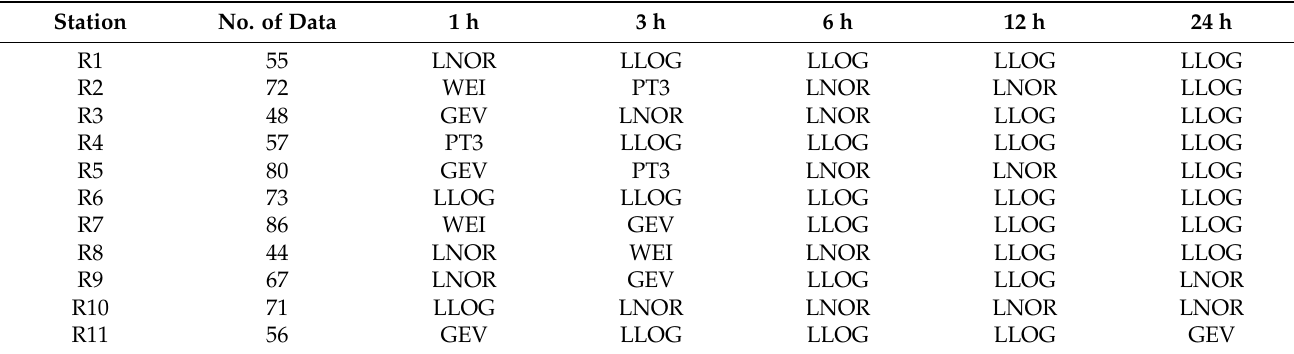
Table 4. Best-fit probability distribution functions used for computing standardized time series of annual maxima of rainfall. Five different probability distributions were considered: generalized extreme value (GEV), Weibull (WEI), Pearson Type III (PT3), lognormal (LNOR) and loglogistic